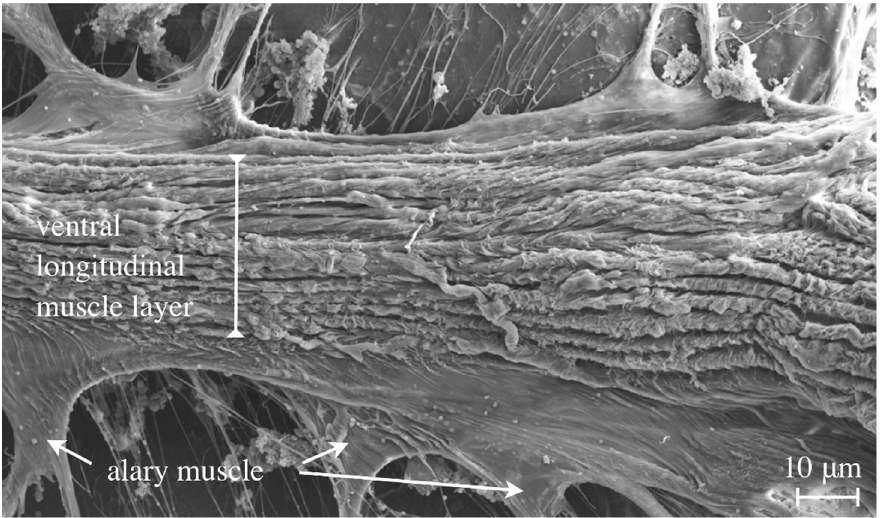
Figure 6. An adult fly was dissected, prepared for Scanning-EM and viewed from the ventral side (inside-out) to demonstrate the layer of ventral longitudinal muscles that run from anterior to posterior underneath the heart